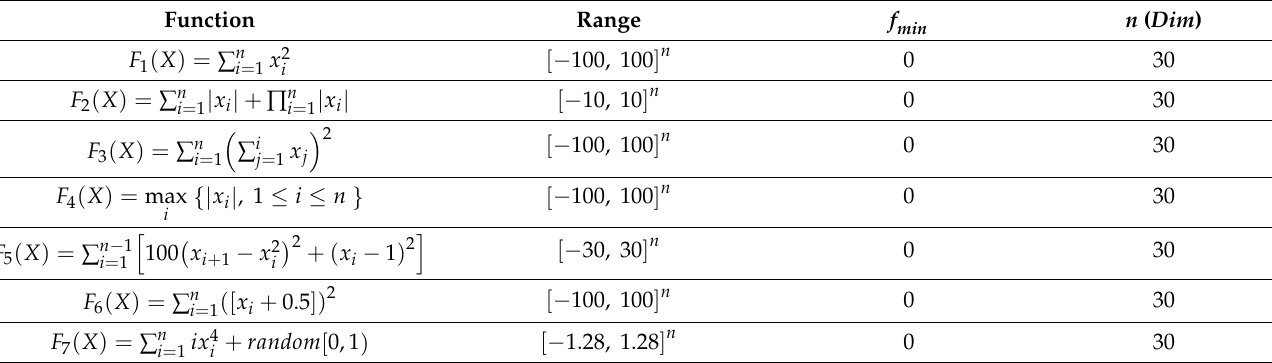
Table 2. Description of unimodal benchmark functions.